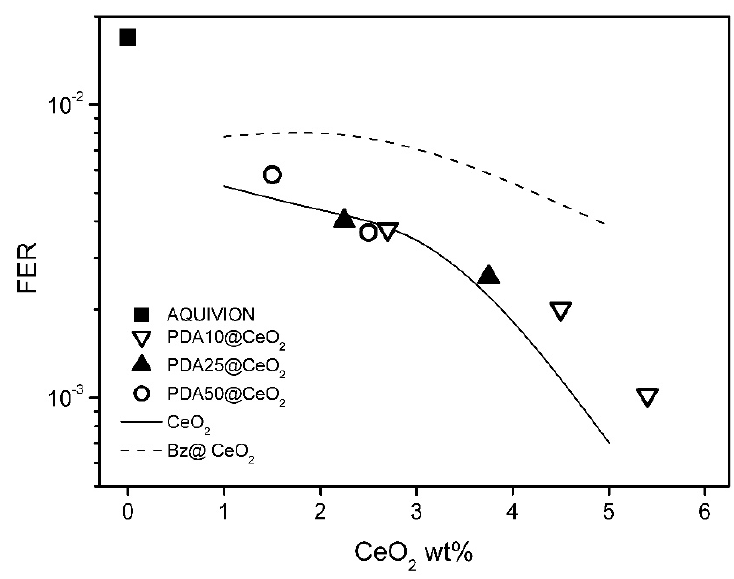
Figure 10. Fluoride emission rate (FER) as a function of CeO 2 content for composite Aquivion membranes filled with PDA10@CeO 2 , PDA25@CeO 2 and PDA50@CeO 2 . The FER of composite Aquivion membranes containing bare CeO 2 and Bz@CeO 2 (redrawn from ref. [16]) is reported for comparison.